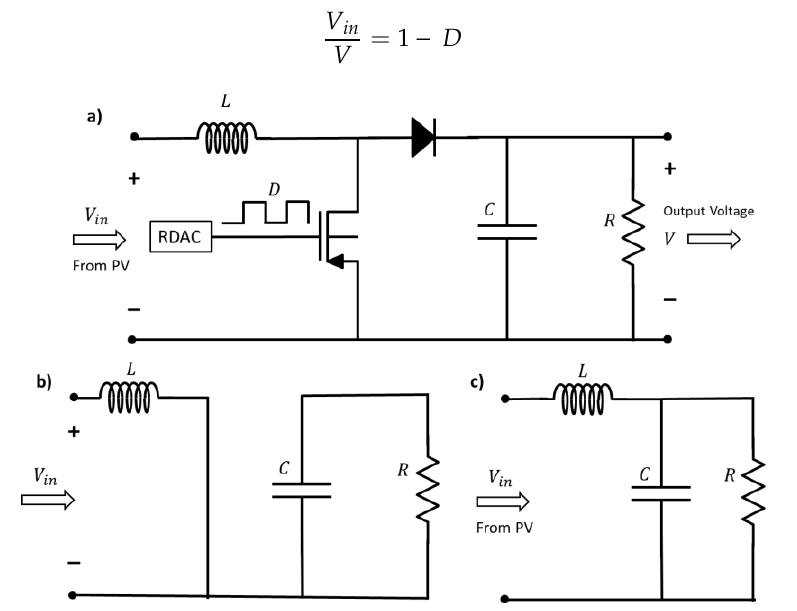
Figure 4. The Boost converter topology. ( a ) Boost converter circuit, ( b ) switch on mode, and ( c ) switch off mode.